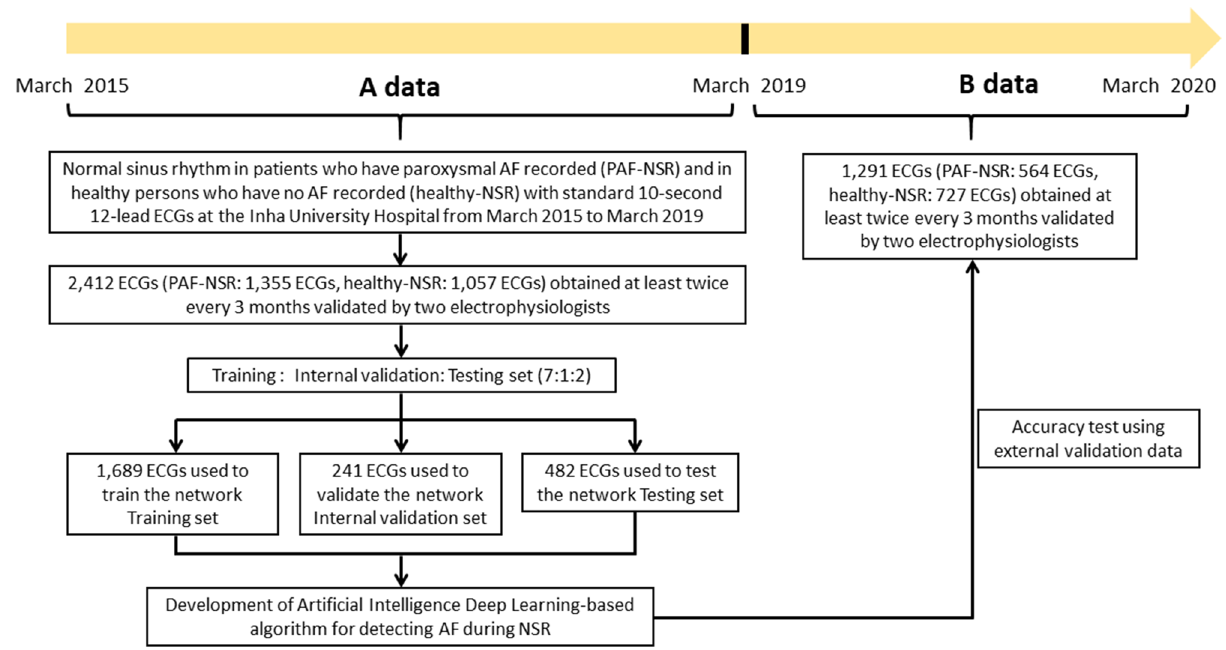
Figure 1. Patient flow diagram showing the selection of the study population and the creation of the study datasets. ECGs were allocated to the training, internal validation, and testing datasets in a 7:1:2 ratio to assure a